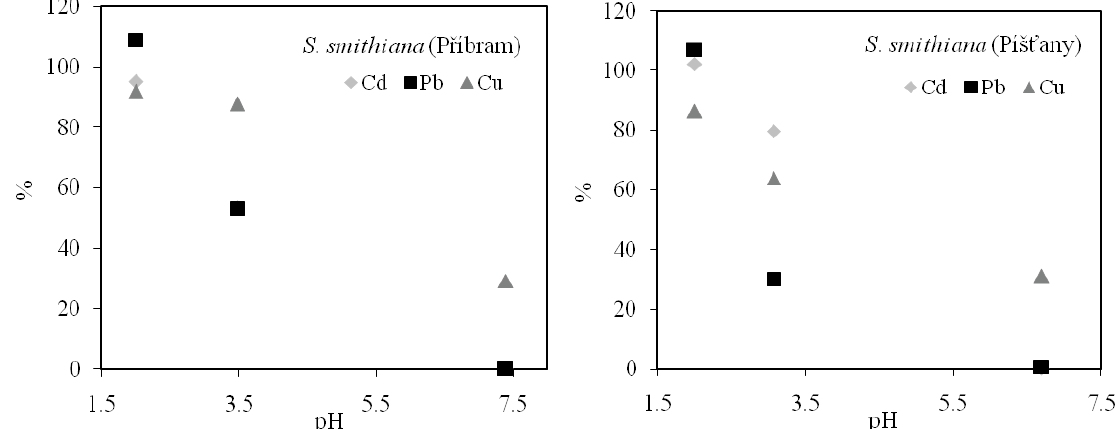
Figure 3. Dependence of ionic portion (in %) measured by DP-ASV on pH of Salix smithiana Smith soil solution grown at two localities. The total contents of metals were measured by ET-AAS and amount to 100%.